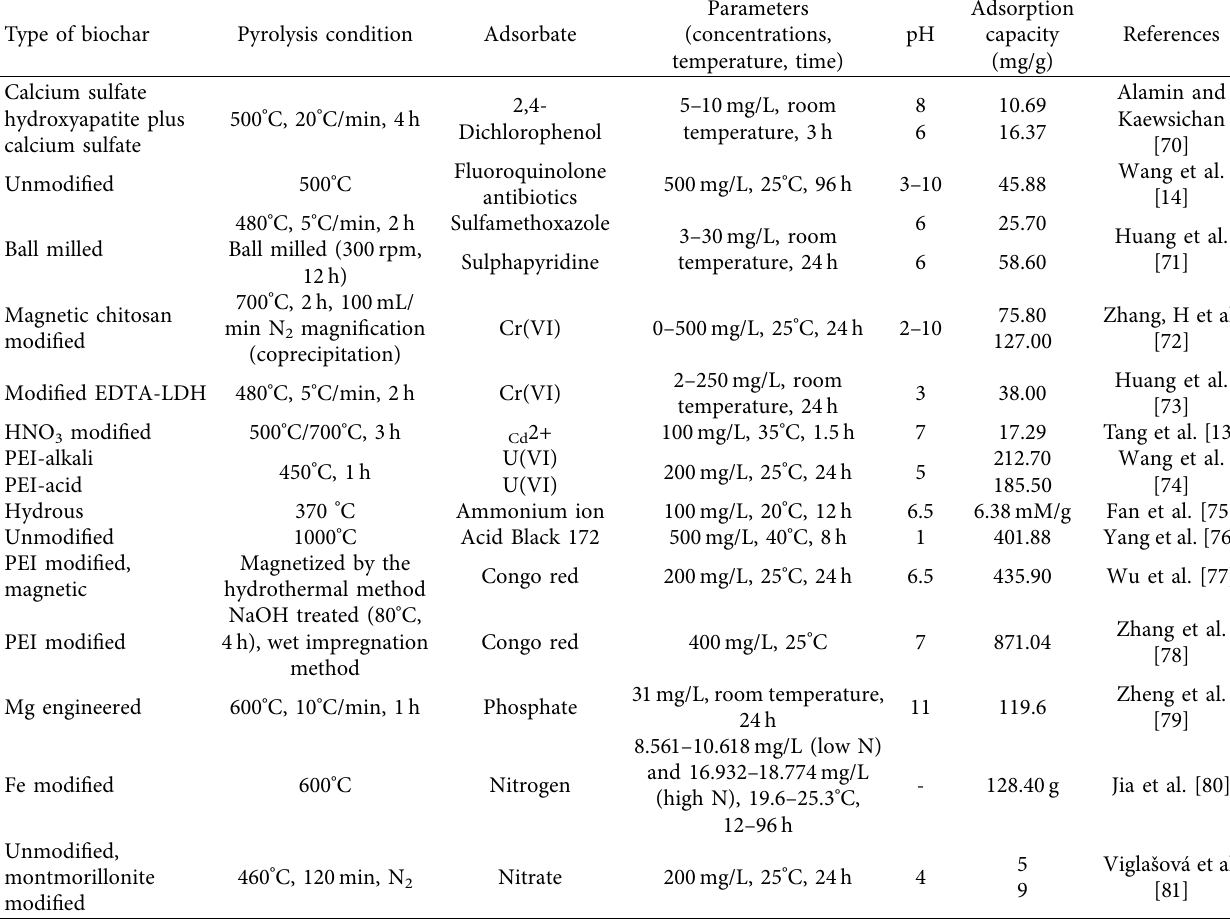
Table 2: Adsorption capacities of contaminant/pollutants removal by biochar derived from